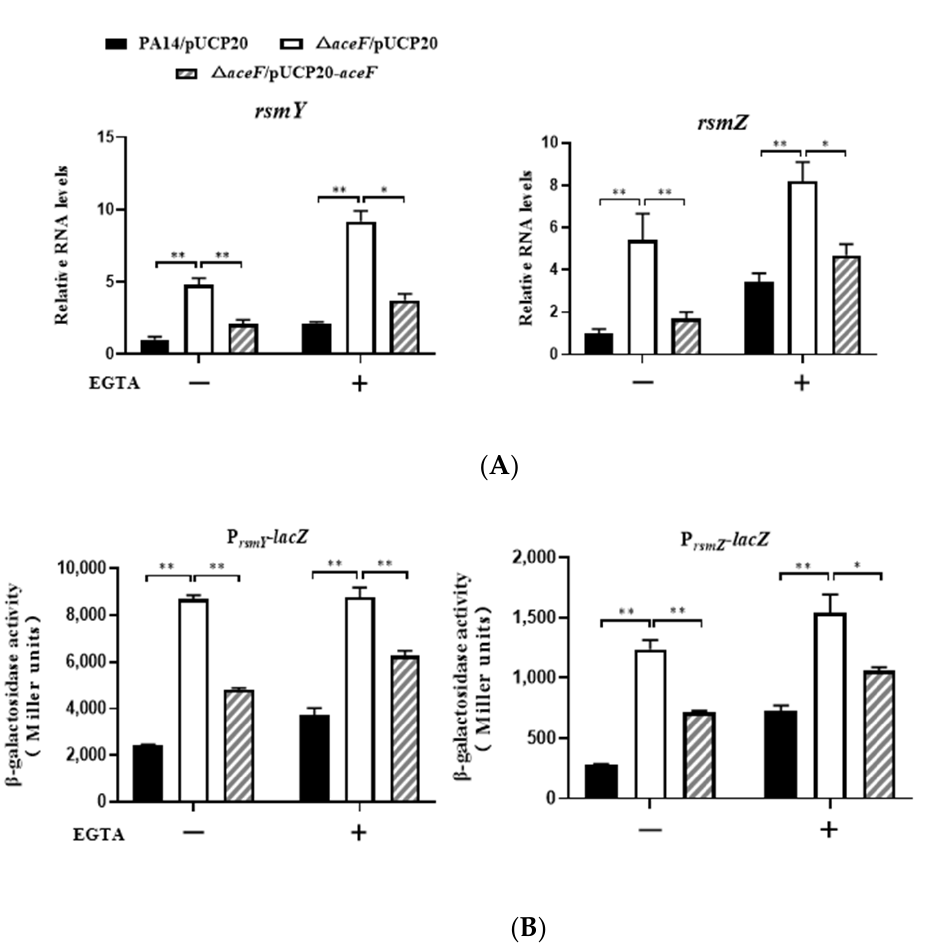
Figure 3. Mutation of the aceF gene upregulates rsmY and rsmZ . ( A ) The bacteria were grown in LB with or without 5mM EGTA to an OD 600 of 1. The RNA levels of rsmY and rsmZ were determined by real-time PCR. ( B ) PA14, the ∆ aceF mutant and the complemented strain containing the P rsmY - lacZ ( left ) and P rsmZ - lacZ ( right ) transcriptional fusion were cultured in LB with or without 5mM EGTA to an OD 600 of 1, followed by determination of the β -galactosidase activity. Data shown represent mean ± standard error of mean from three samples. * p < 0.05; ** p < 0.01 by